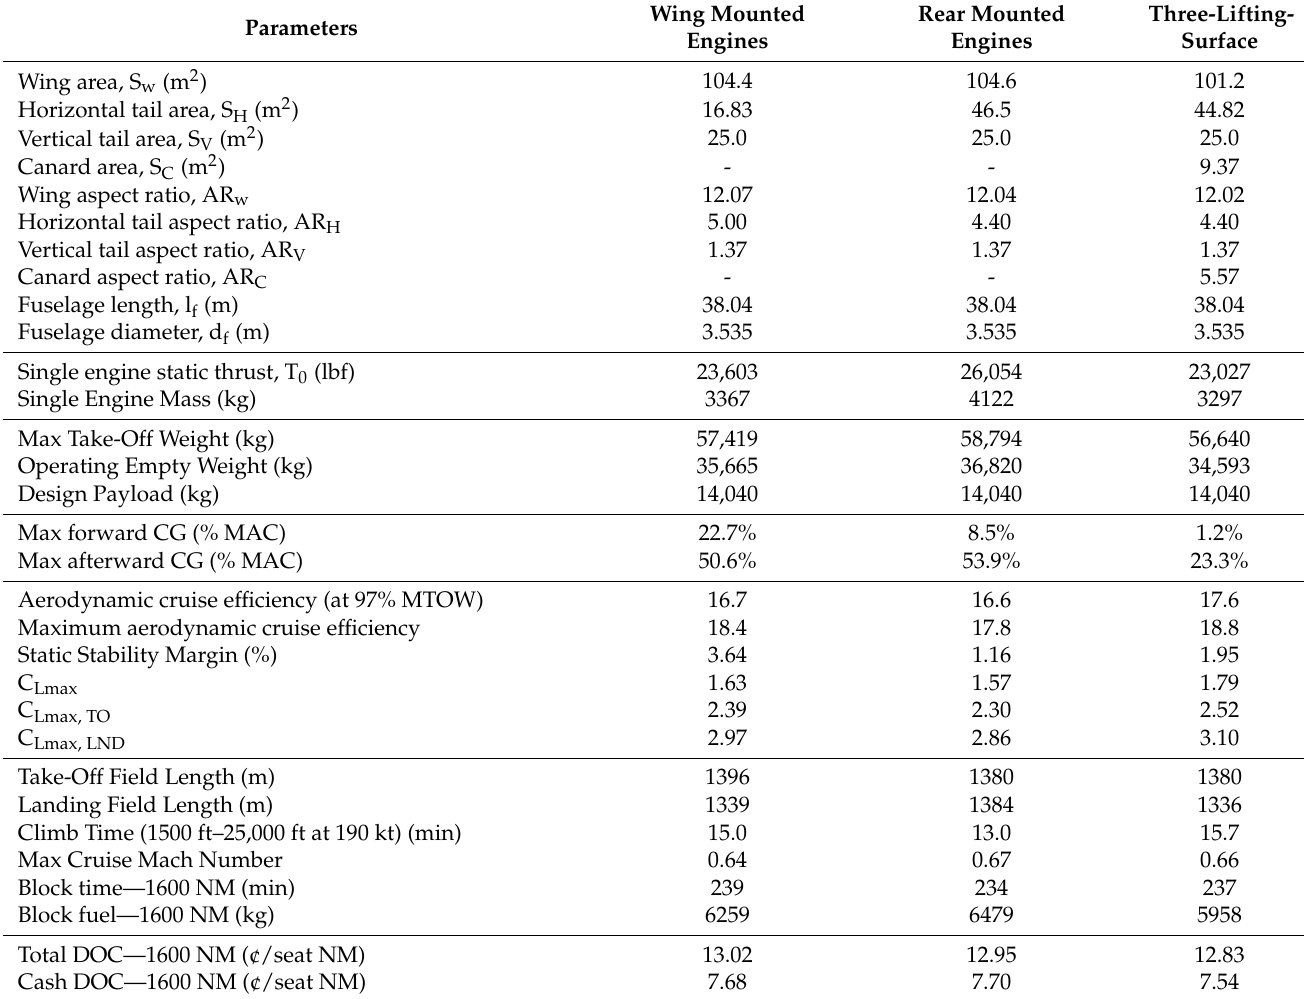
Table 4. Comparison between optima large capacity turboprop